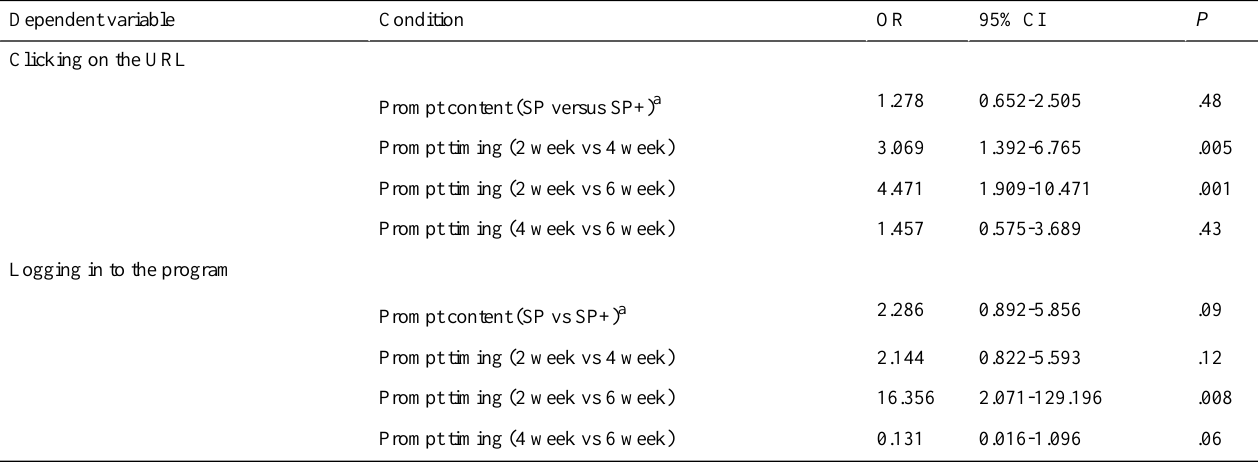
Table 2. Effects of prompt content and timing on clicking on the URL (step 1) and logging in to the program (step